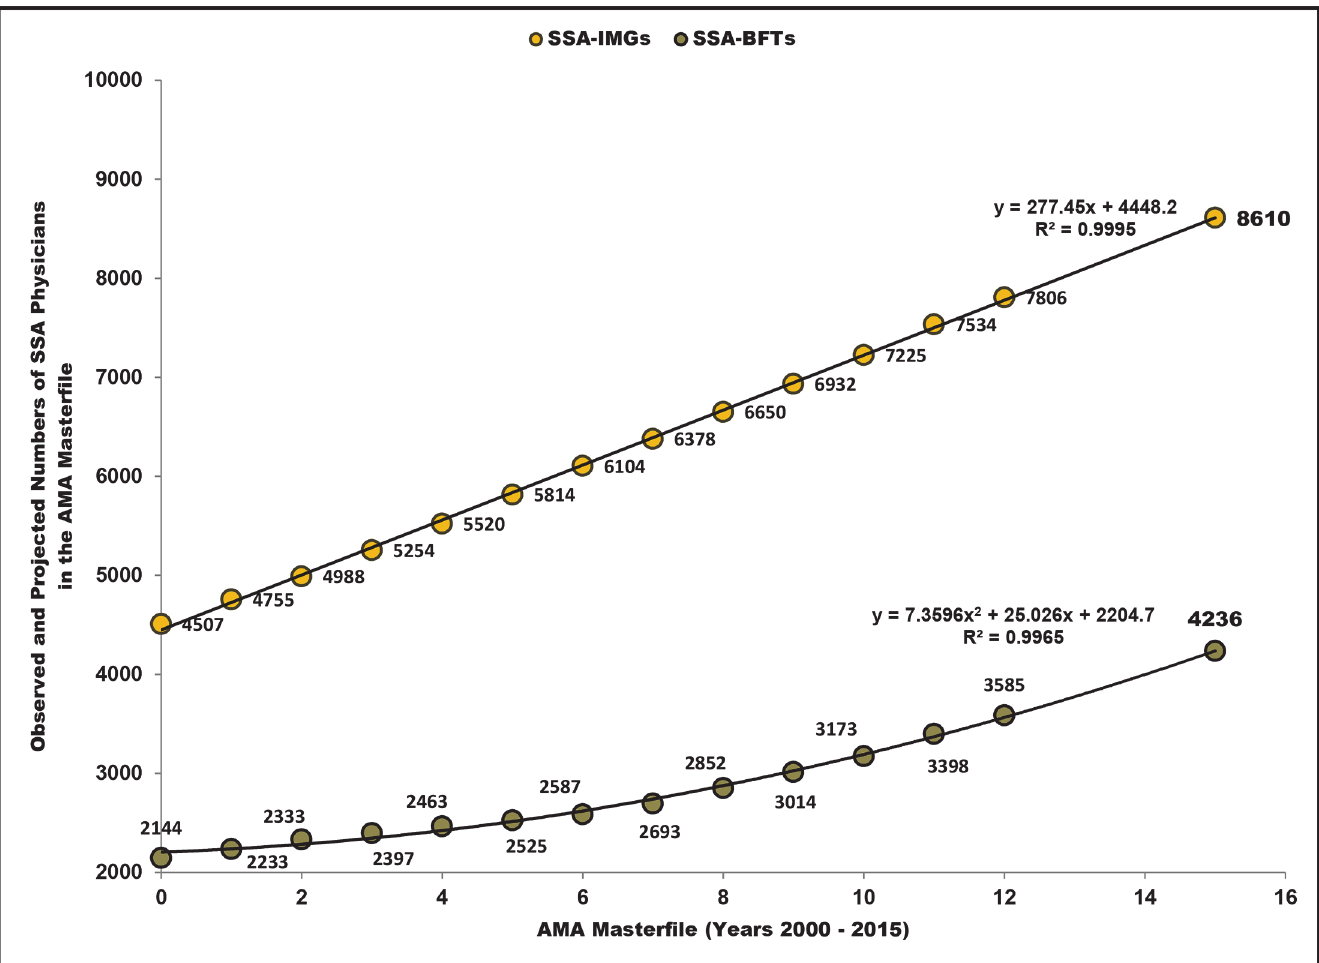
Fig 1. Projected numbers of active and semi-retired Sub-Saharan African (SSA) migrant physicians in the 2015 American Medical Association (AMA) Physician Masterfile. Note: Based on available residency completions and expected completions of active and semi-retired Sub-Saharan African migrant physicians in the 2013 AMA Physician Masterfile [27]; SSA-IMGs, international medical graduates trained in SSA-based medical schools; SSA-BFTs, SSA-born, but foreign-trained physicians (including US medical graduates and international medical graduates trained in non-SSA-based medical